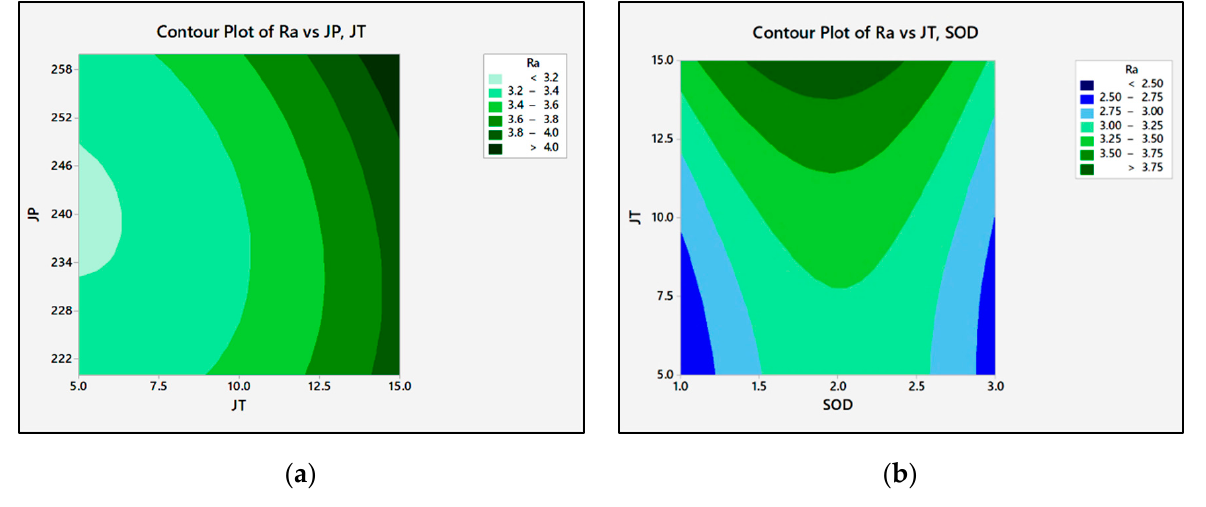
Figure 5. The contour plots of Ra: ( a ) Ra vs P, JT; ( b ) Ra vs. JT, SOD.